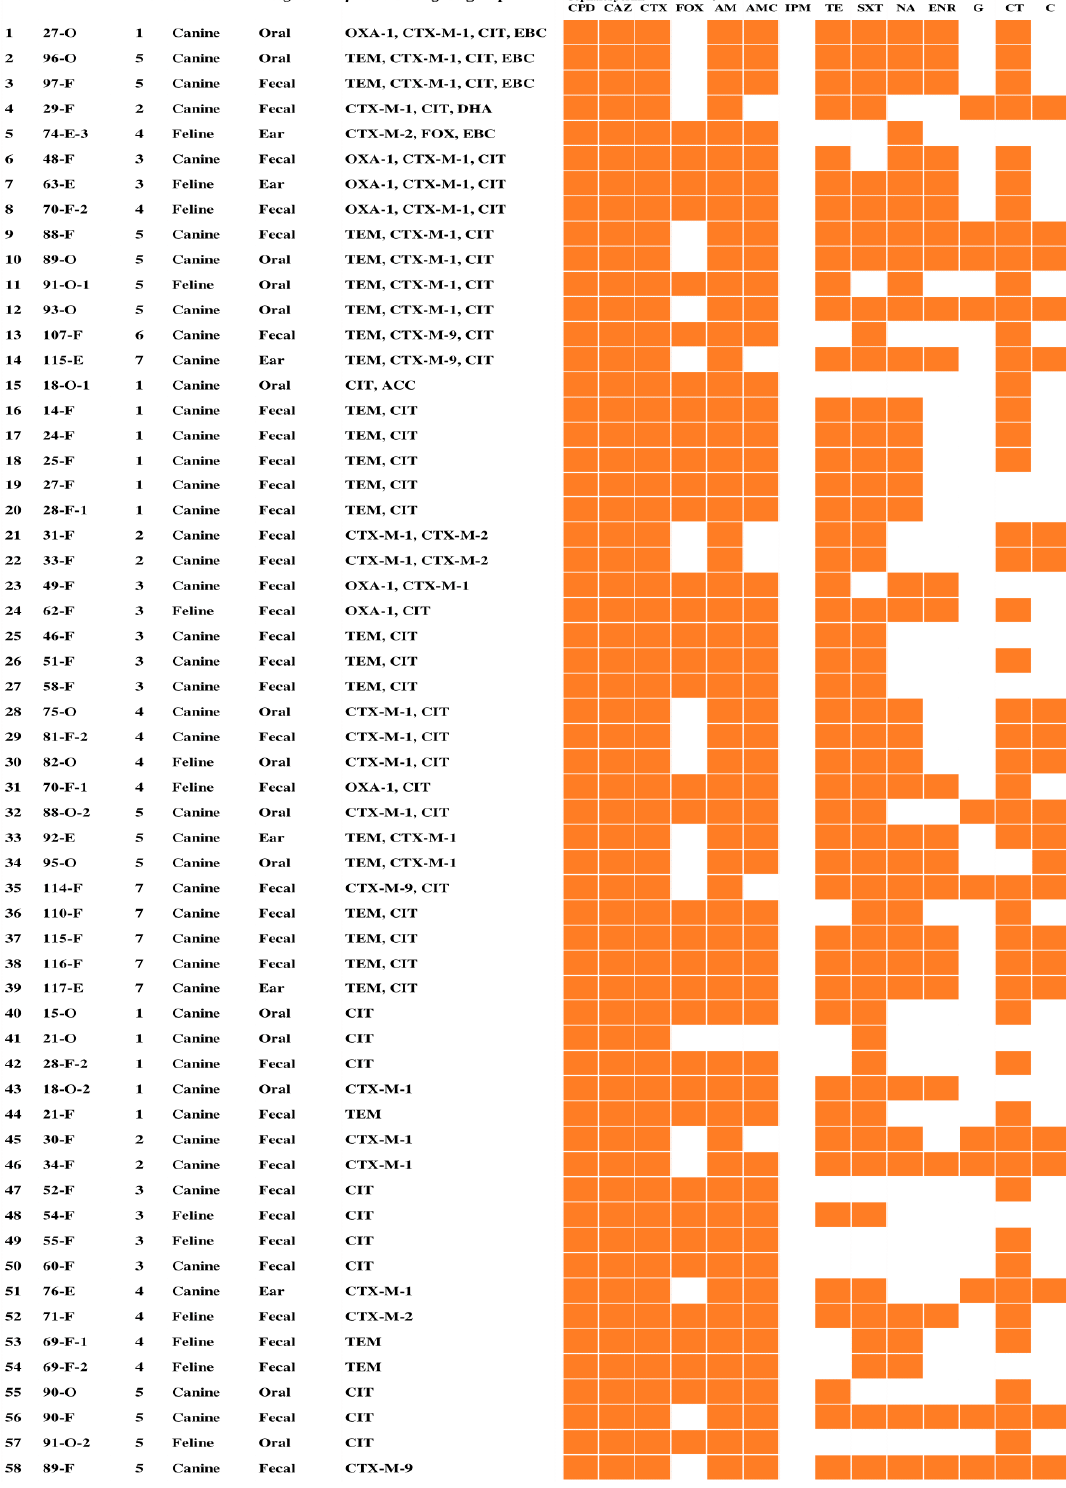
Figure 2. Characteristics of 58 ESBL- and pAmpC β -lactamase-producing E. coli isolates from dogs and cats. CPD, cefpodoxime; CAZ, ceftazidime; CTX, cefotaxime; FOX, cefoxitin; AM, ampicillin; AMC, amoxicillin-clavulanate; IPM, imipenem; TE, tetracycline; SXT, trimethoprim/sulfamethoxa- zole; NA, nalidixic acid; ENR, enrofloxacin; G, gentamicin; CT, colistin; C, chloramphenicol.